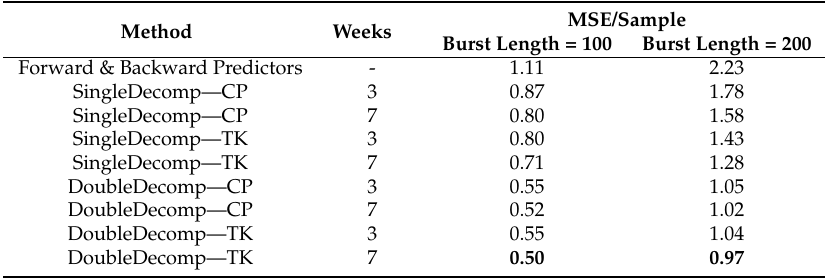
Figure 6. Data tensorization of a 3 week tensor with 200 samples of lost data bursts. In ( a ) the green line shows the original data, and the red line shows the lost burst. The soft blue window shows the data introduced in burst-centered tensor, which forces the burst to be in the center of the window. Panels ( b ) shows how the continuous flow of data in the soft blue window is fragmented to be allocated in the tensor as shown in panel ( c ). Table 3. Algorithms’ performance in terms of the MSE per